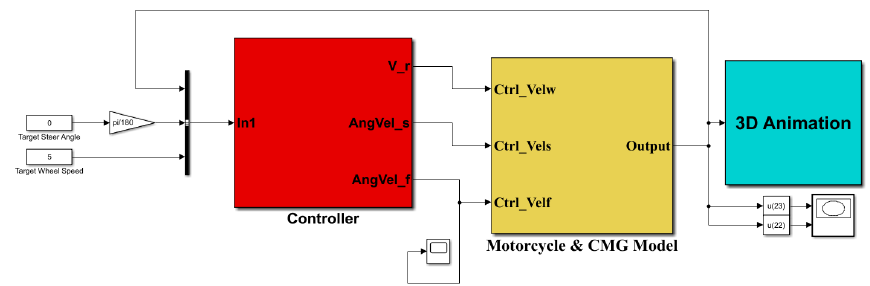
Figure 9. Simulink Environment. Table 2. DC servo motor parameter table.